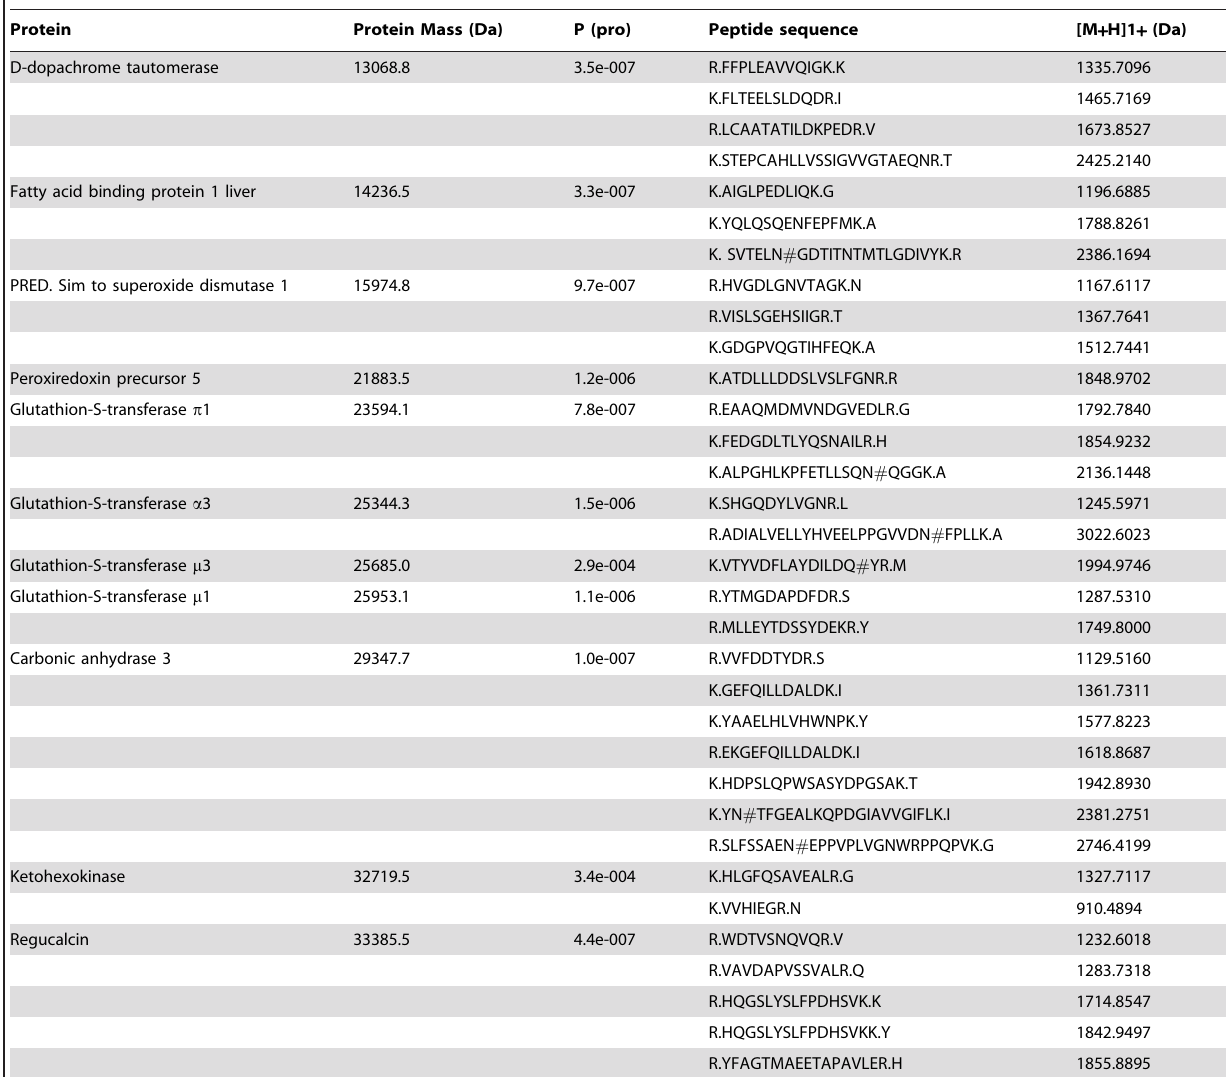
Table 2. Proteins identified with